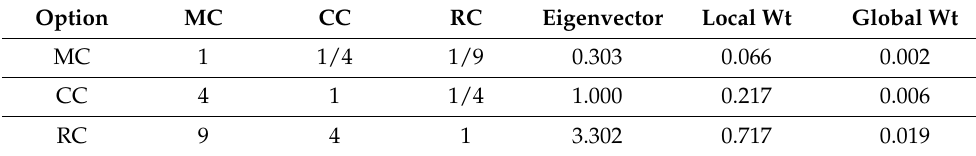
Table A12. Comparison of alternatives matrix for subcriterion SA8.